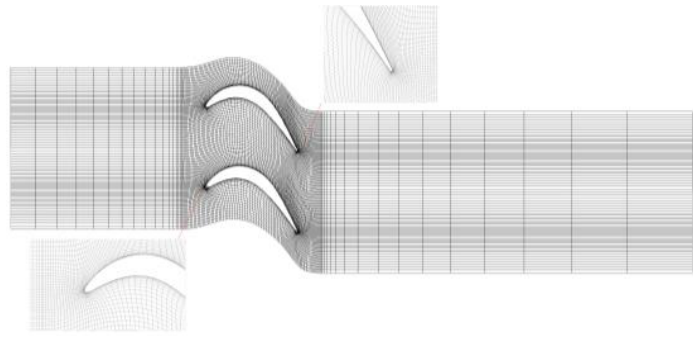
Figure 6. Computational meshes for Pak B cascade.